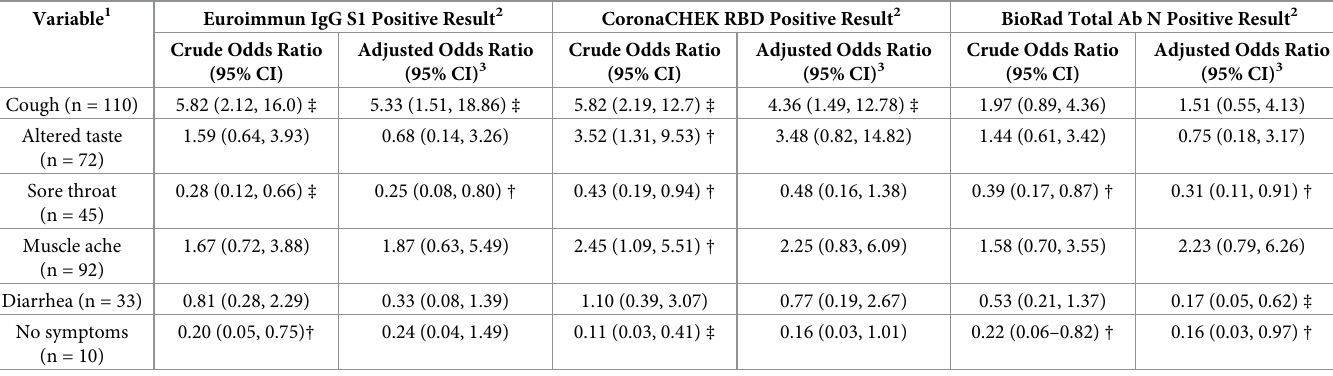
Table 2. The association between symptoms and antibody reactivity to S1, RBD and N proteins of SARS-CoV-2 among infected individuals. Variable 1